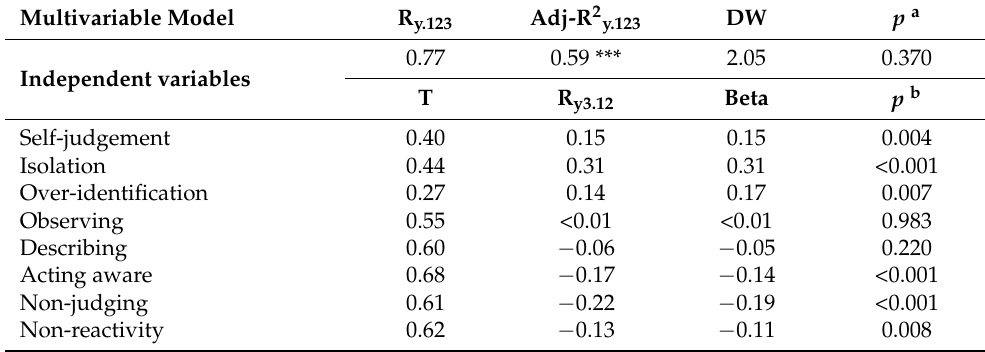
Table 4. Explanatory power of self-compassion and mindfulness facets on AAQ-II. Multivariable Model